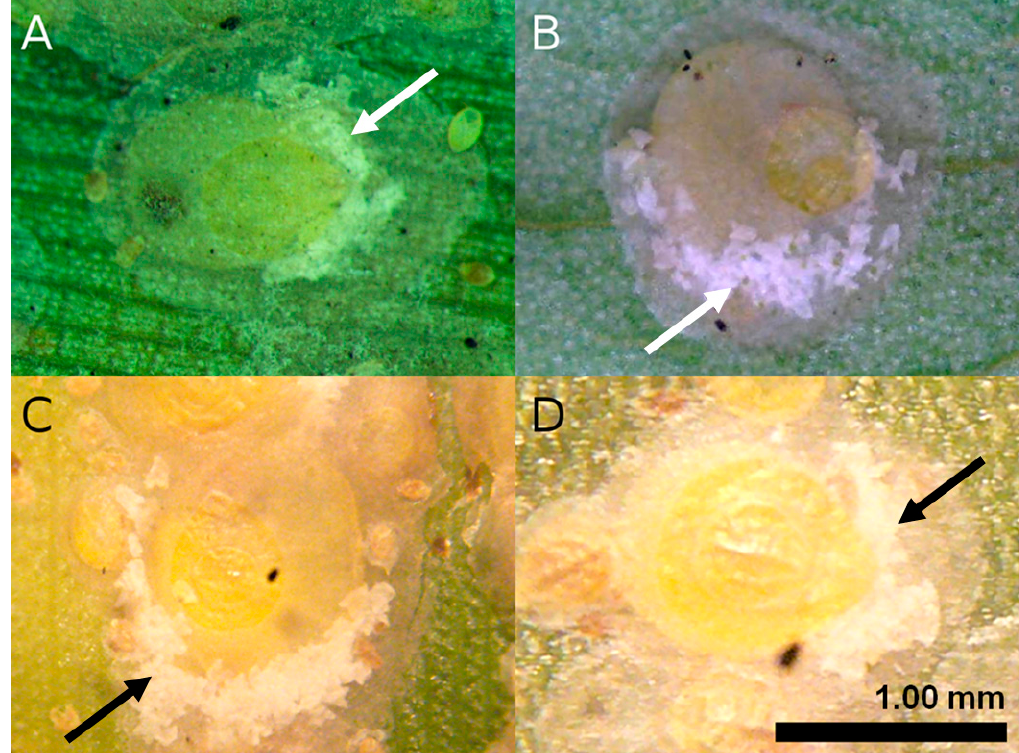
Figure 2. Representative adult female A. rigidus from different outbreak areas: ( A ) Southern Tagalog Region (Laguna, Cavite, and Batangas); ( B ) Orani, Bataan; ( C ) Basilan; and ( D ) Zamboanga City. The arrows point to the egg skins, which for this species is characteristically distributed along the posterior or pygidial half of the insect body.